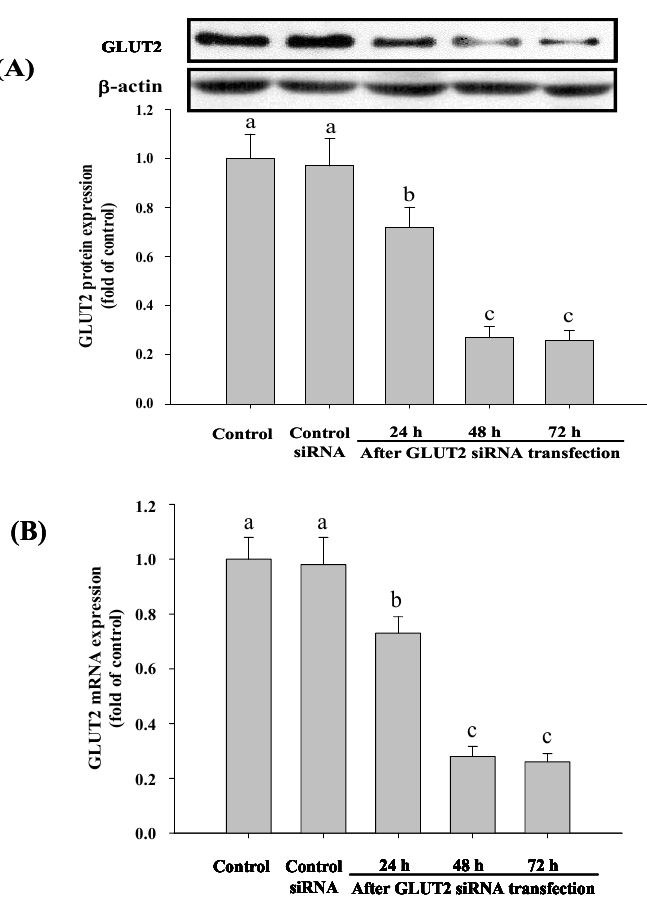
Figure 4. Expression of GLUT2 in Caco-2 cells after siRNA transfection. Caco-2 cells were treated with GLUT2 siRNA for 24, 48 and 72 h. Comparative expression of GLUT2 was then assessed by western blotting ( A ) and real-time PCR ( B ), respectively. Values without a common letter differ, p <